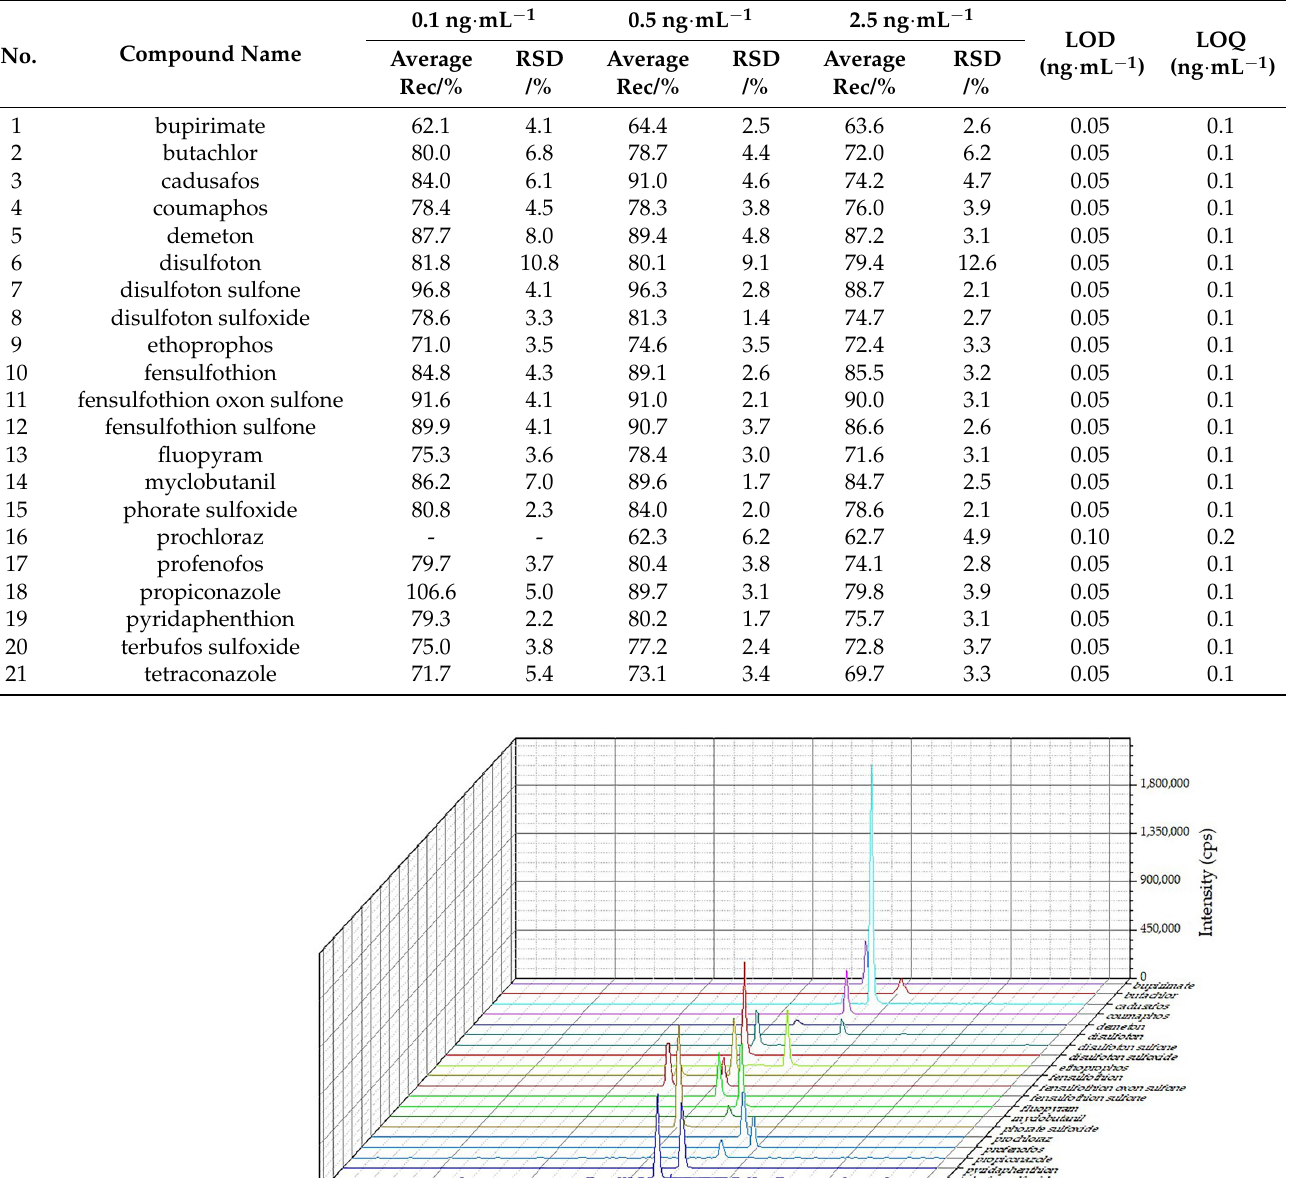
Table 2. The method performance of 21 targets in D- µ SPE process.